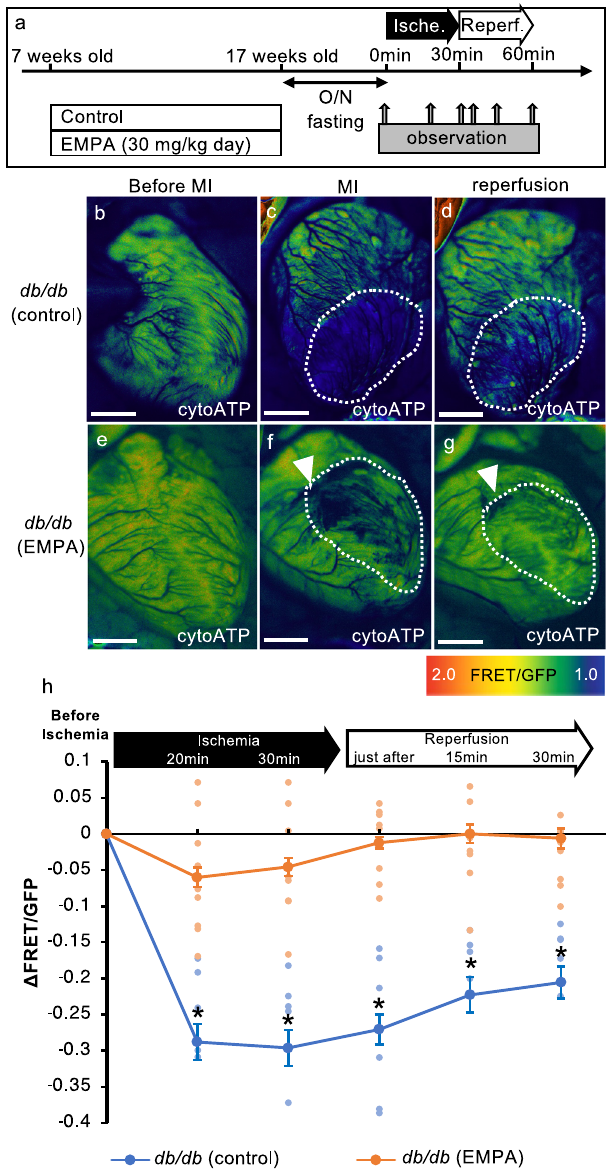
maintaining cytosolic ATP levels in the infarcted region of T2D hearts. a Schematic illustration of the treatment regimen (EMPA empagli fl ozin). b – g Fluorescence images of a live heart from each condition (EMPA empagli fl ozin). Arrowheads show the sites of punctuation with a suture needle to induce ischemia. Dotted lines show the infarct regions. Warmer colors indicate higher ATP concentrations. Scale bar: 2mm. h Time